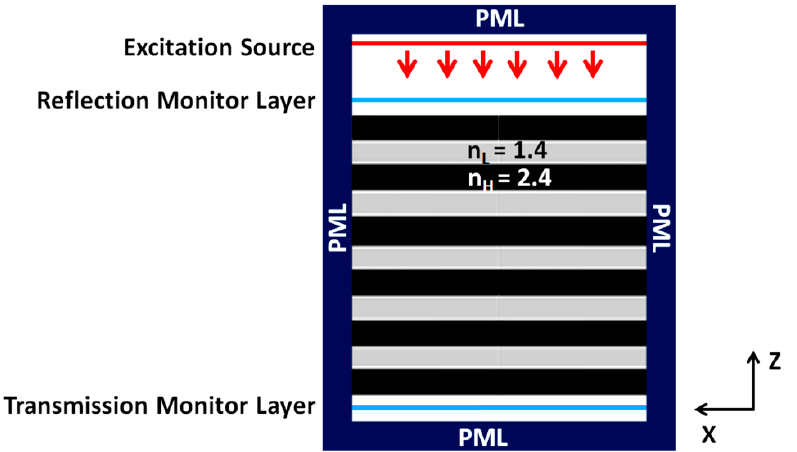
Figure 7. A finite 2D-FDTD simulation model of the hybrid DBR-PhC structure, representing the positions of the excitation source, reflection and transmission monitoring layers, and PML boundaries.